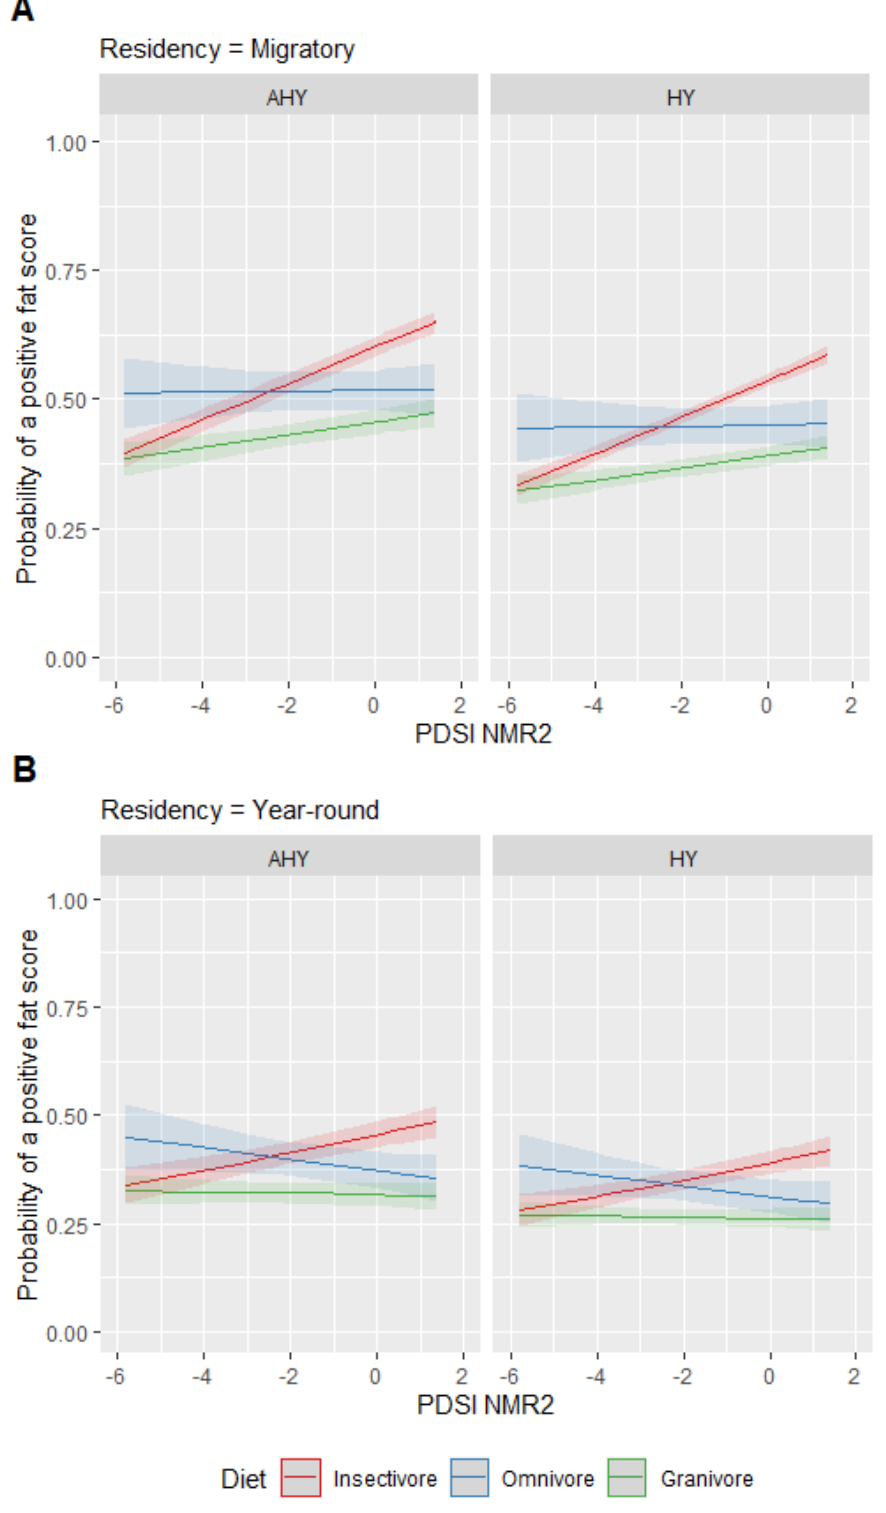
Figure 3. Probability of receiving a positive fat score based on ( A ) migratory versus ( B ) year-round residency for age (AHY = after hatch year, HY = hatch year) and diet (insectivore, granivore, and omnivore) in relation to the Palmer Drought Severity Index for New Mexico region 2 (NM region 2).